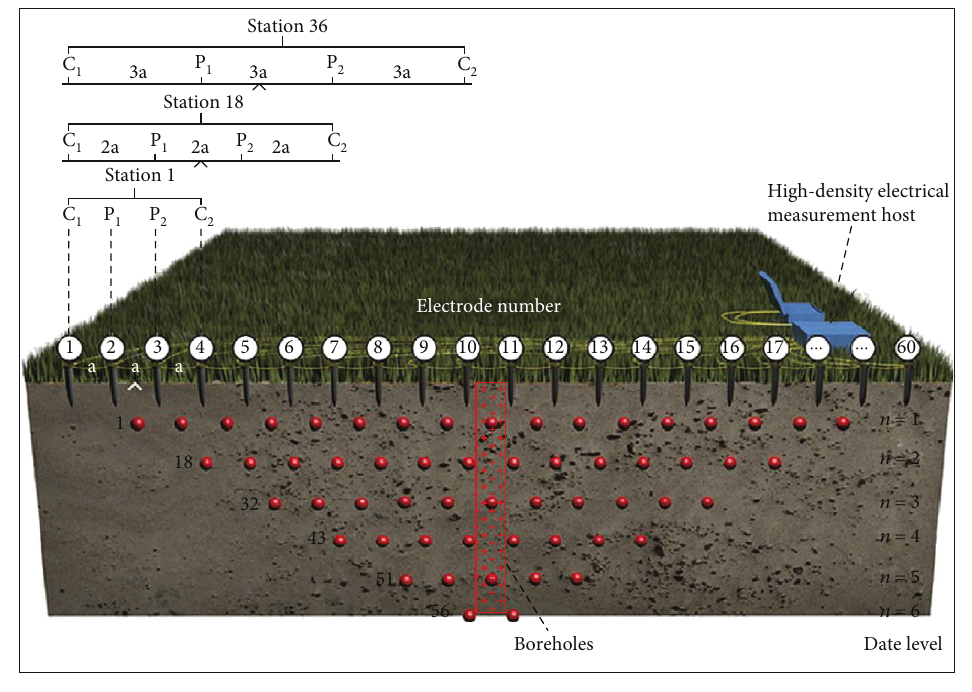
Figure 3: The distribution diagram of Wenner-Alpha method.